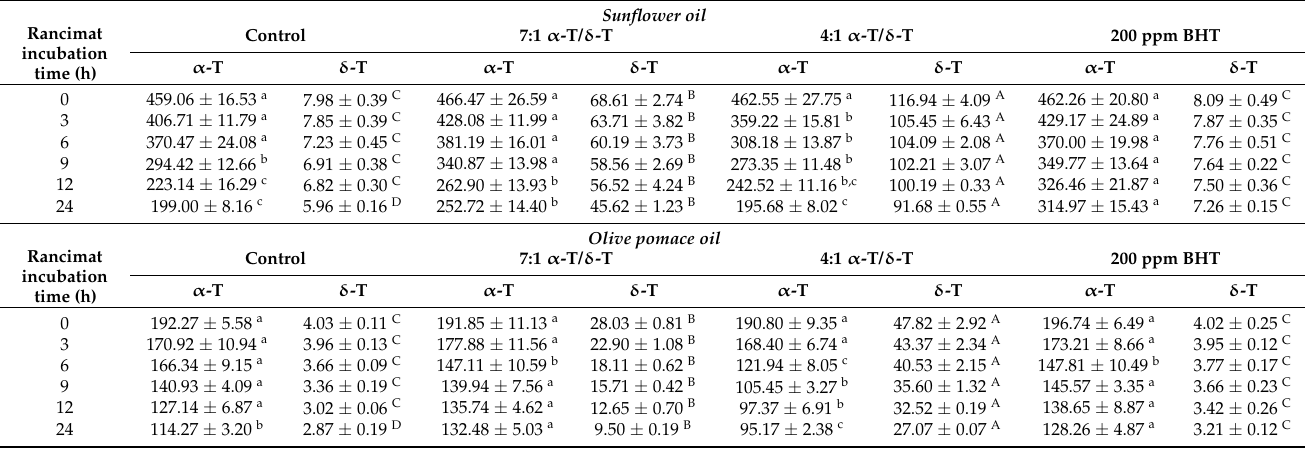
Table 3. Tocopherol contents (mg/Kg oil ± SD) in sunflower oil and olive pomace oil samples. Inside rows with a specific superscript letter (e.g., a–c for α -T values and A–D for δ -T values) indicate a significant ( p < 0.05) difference for each Rancimat incubation